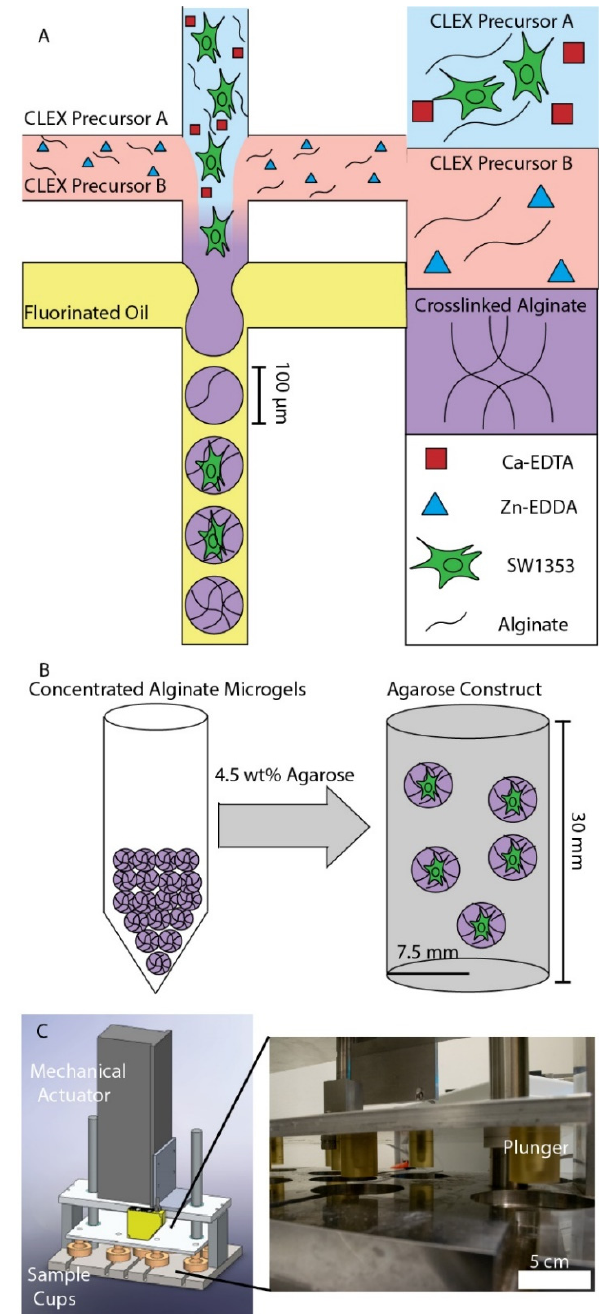
Figure 1. Experimental workflow: ( A ) Schematic of alginate microgel production. Cell-laden CLEX precursor A was mixed with CLEX precursor B and flow focused with 4% FSH surfactant in HFE 7500 oil. ( B ) After 9 days of culture, concentrated alginate microgels were mixed with agarose to a final agarose concentration of 4.5% w / w and 80% v / v . ( C ) After 2 days, a custom-built bioreactor applied 5 ± 2% cyclic strain to the agarose constructs containing alginate microgels. Following cyclic compression, metabolites were extracted from the samples and analyzed using HPLC–MS. In the close-up image ( C right), the sample cups were removed to visualize the